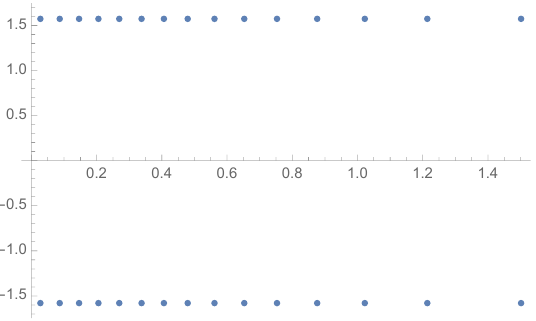
Figure 9 . Bethe roots for L = 32 corresponding to the lowest-energy state in the n = 2 sector with (cid:13) = (cid:25) . 5